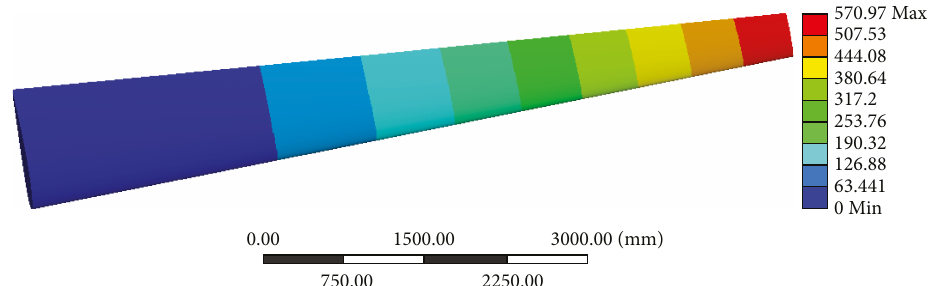
Figure 59: Deformation cloud diagram of full-metallic wing.